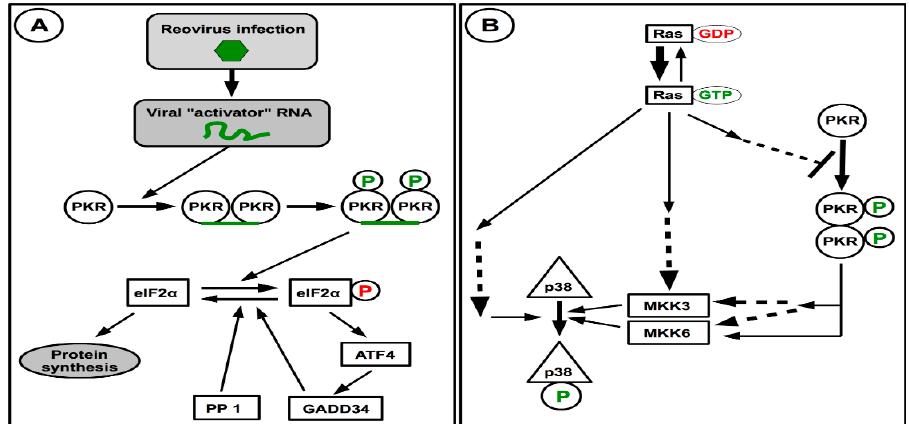
Figure 4. Activation of PKR and interaction with Ras activation and signaling towards p38. ( A ) In infected cells, recognition of a viral RNA results in PKR dimerization, autophosphorylation and activation. While activated PKR can directly phosphorylate eIF2 α resulting in inhibition of protein synthesis, its indirect effect in the stress response by ATF activation could displace the equilibrium towards active unphosphorylated eIF2 α to maintain protein synthesis. ( B ) Activation of the Ras oncogene that results in cell transformation can activate the p38 kinase by different routes. Activation of Ras also inhibits PKR activation by still unknown mechanism, this should result in limited PKR activation and consecutive p38 activation by this route, consecutive to viral infection. Dashed arrows indicate the presence of known or postulated